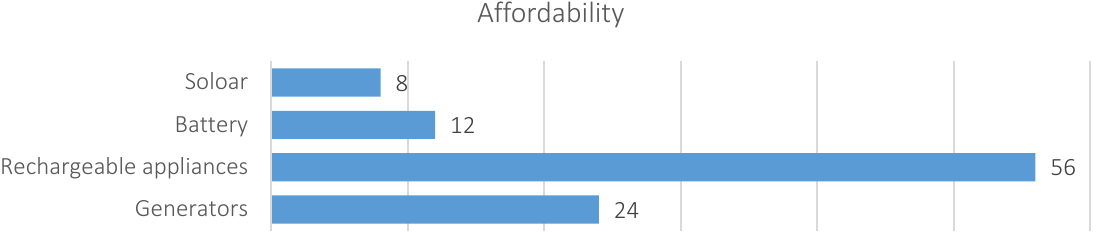
Figure 6. Ratings on